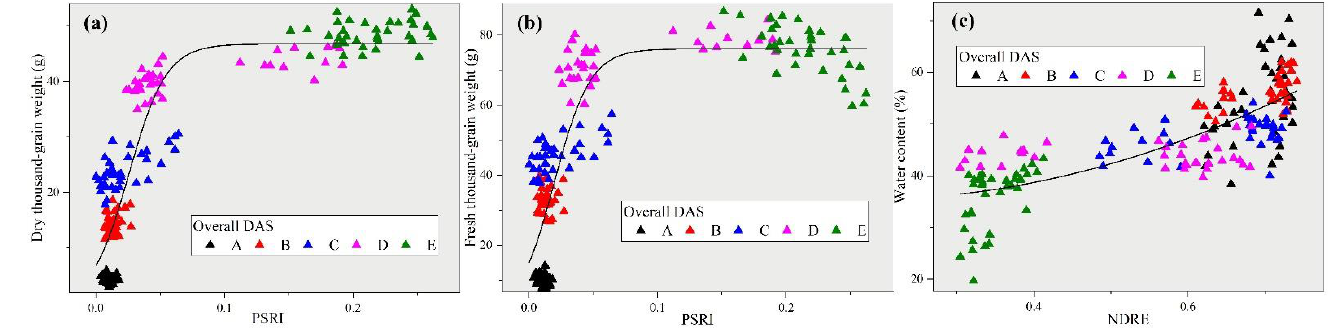
Figure 5. Overall models to monitor dry thousand-grain weight, fresh thousand-grain weight and water content using PSRI ( a , b ) and NDRE ( c ). A – E represent five sampling